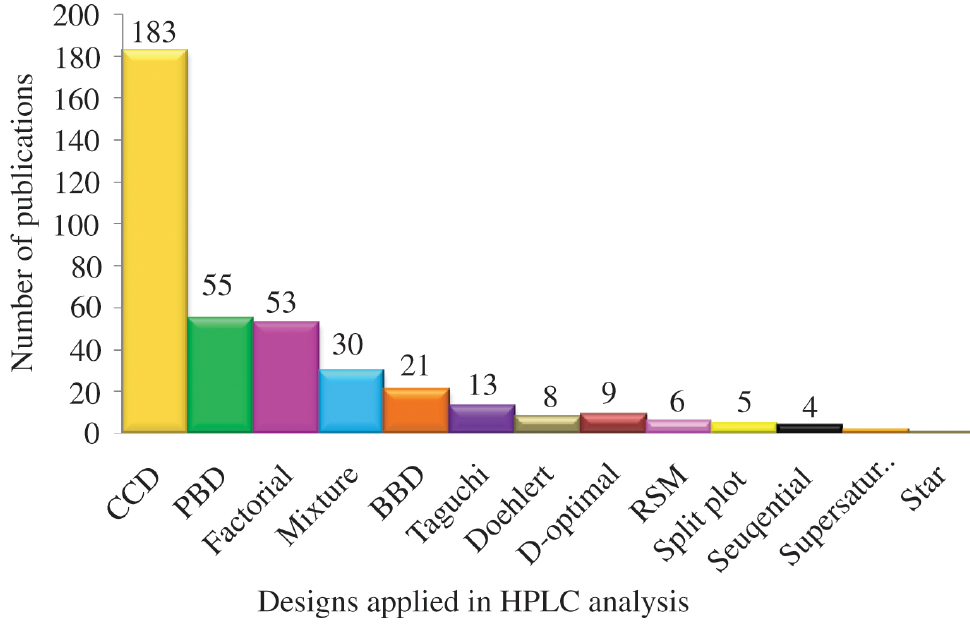
Figure 2: Dominancy of designs for the application in HPLC